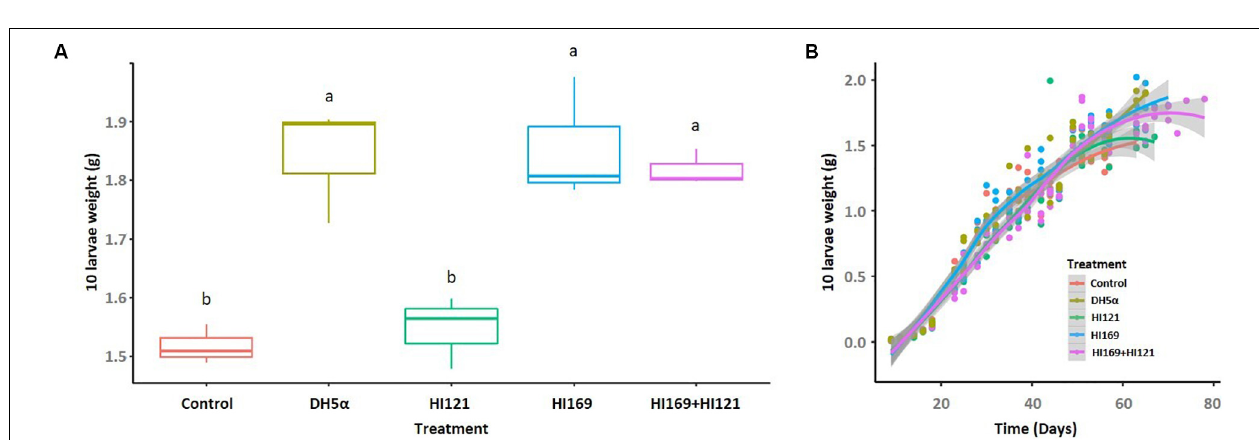
FIGURE 2 | Metabolic activities and EPS production ability for the bacterial isolates obtained from the gut of H. illucens larvae. Bars indicate the percentages of each bacterial class in respect to the analyzed hydrolytic activities and EPS production.